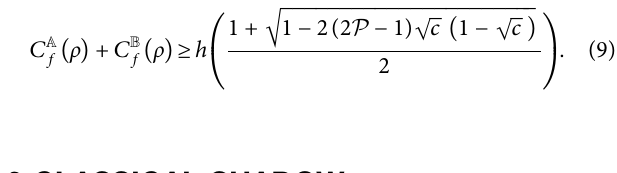
which acts as a completely dephasing channel in polarization